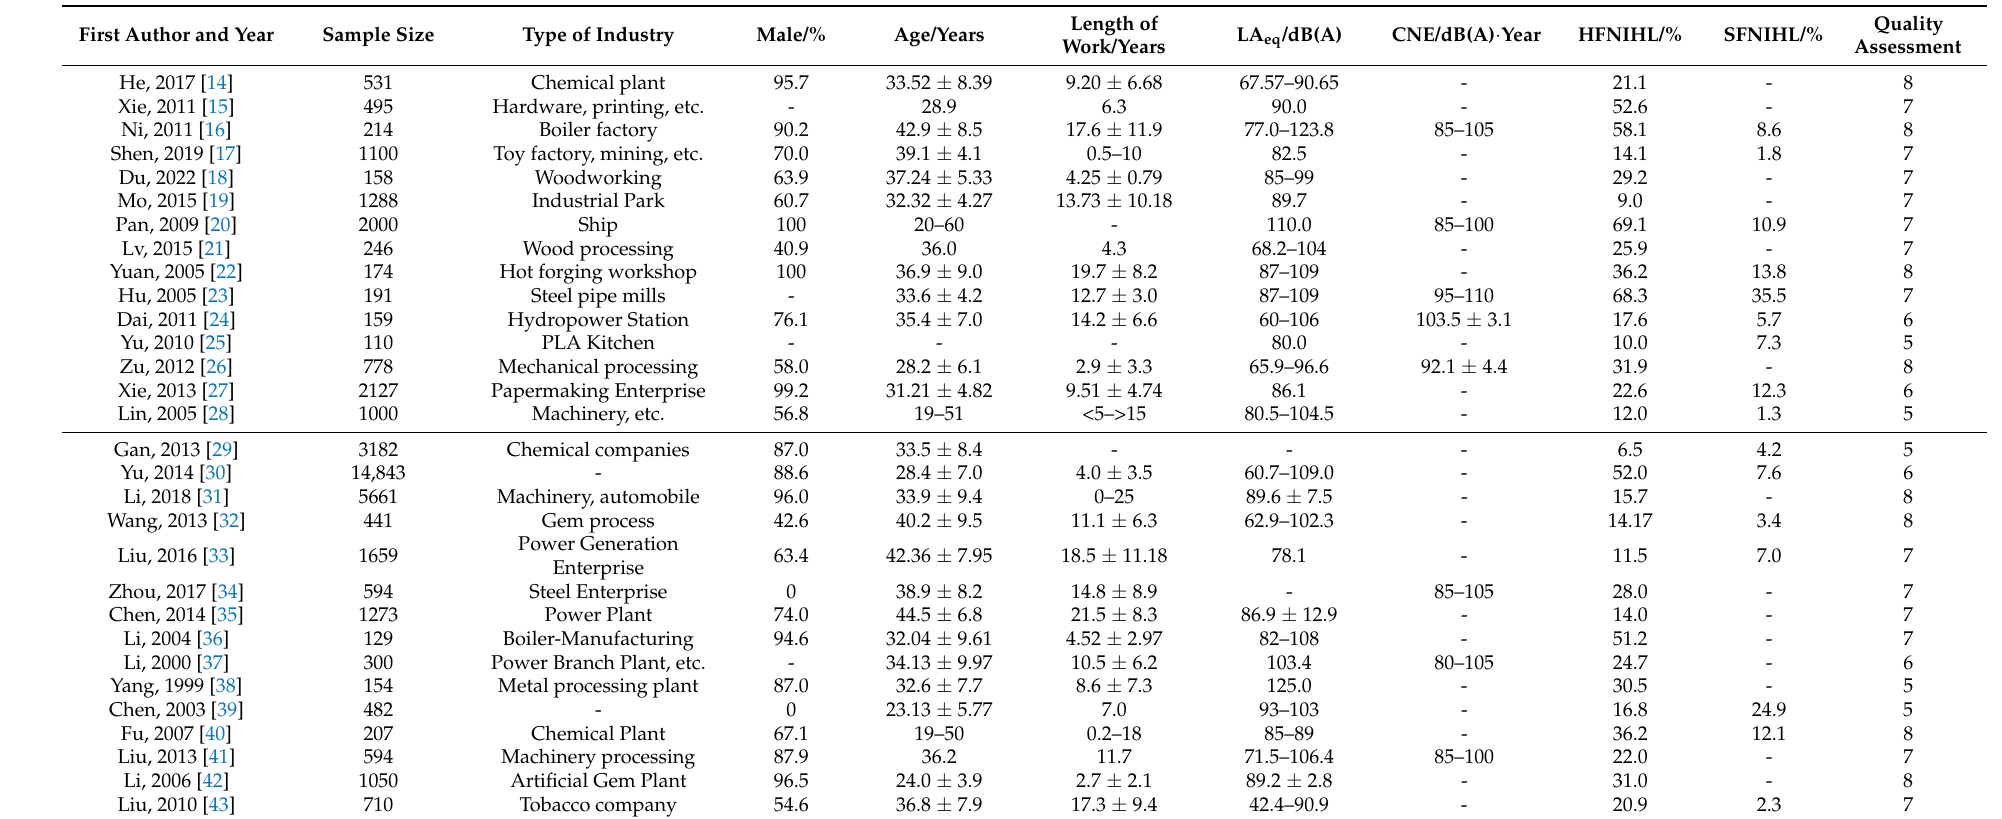
Table 1. Main characteristics of 39 included studies on noise exposure and HFNIHL